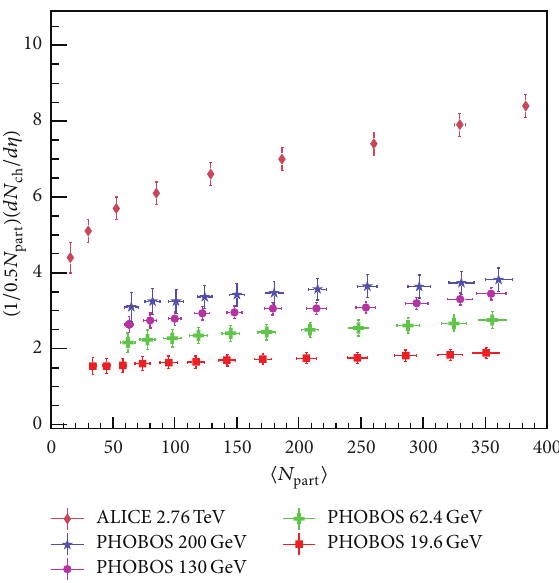
Figure 11: 𝑁 normalized charged particle density for different part collision energies.